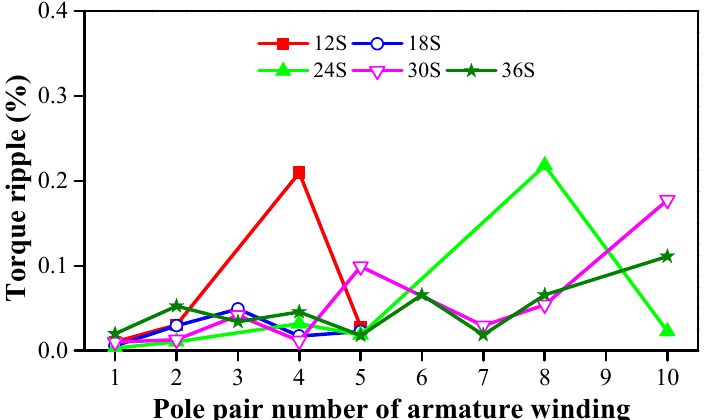
Figure 13. Torque ripples versus armature pole pair number and stator slot number when rotor slot number is selected as N s − P a .